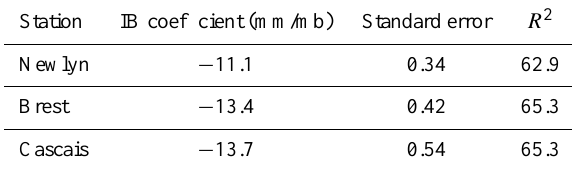
Table 2. Regression models – IB response.